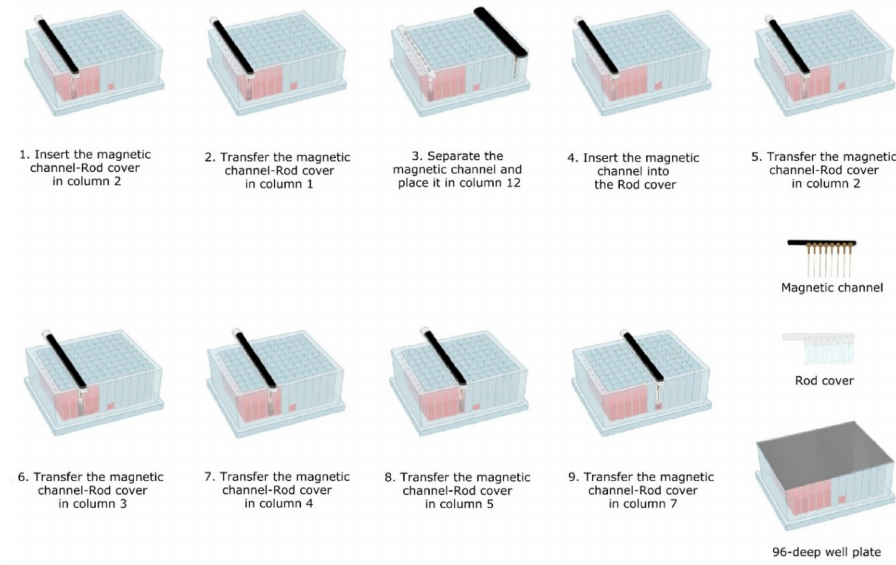
Figure 3. Workflow performed for the Triple E easy-lab and point-of-care